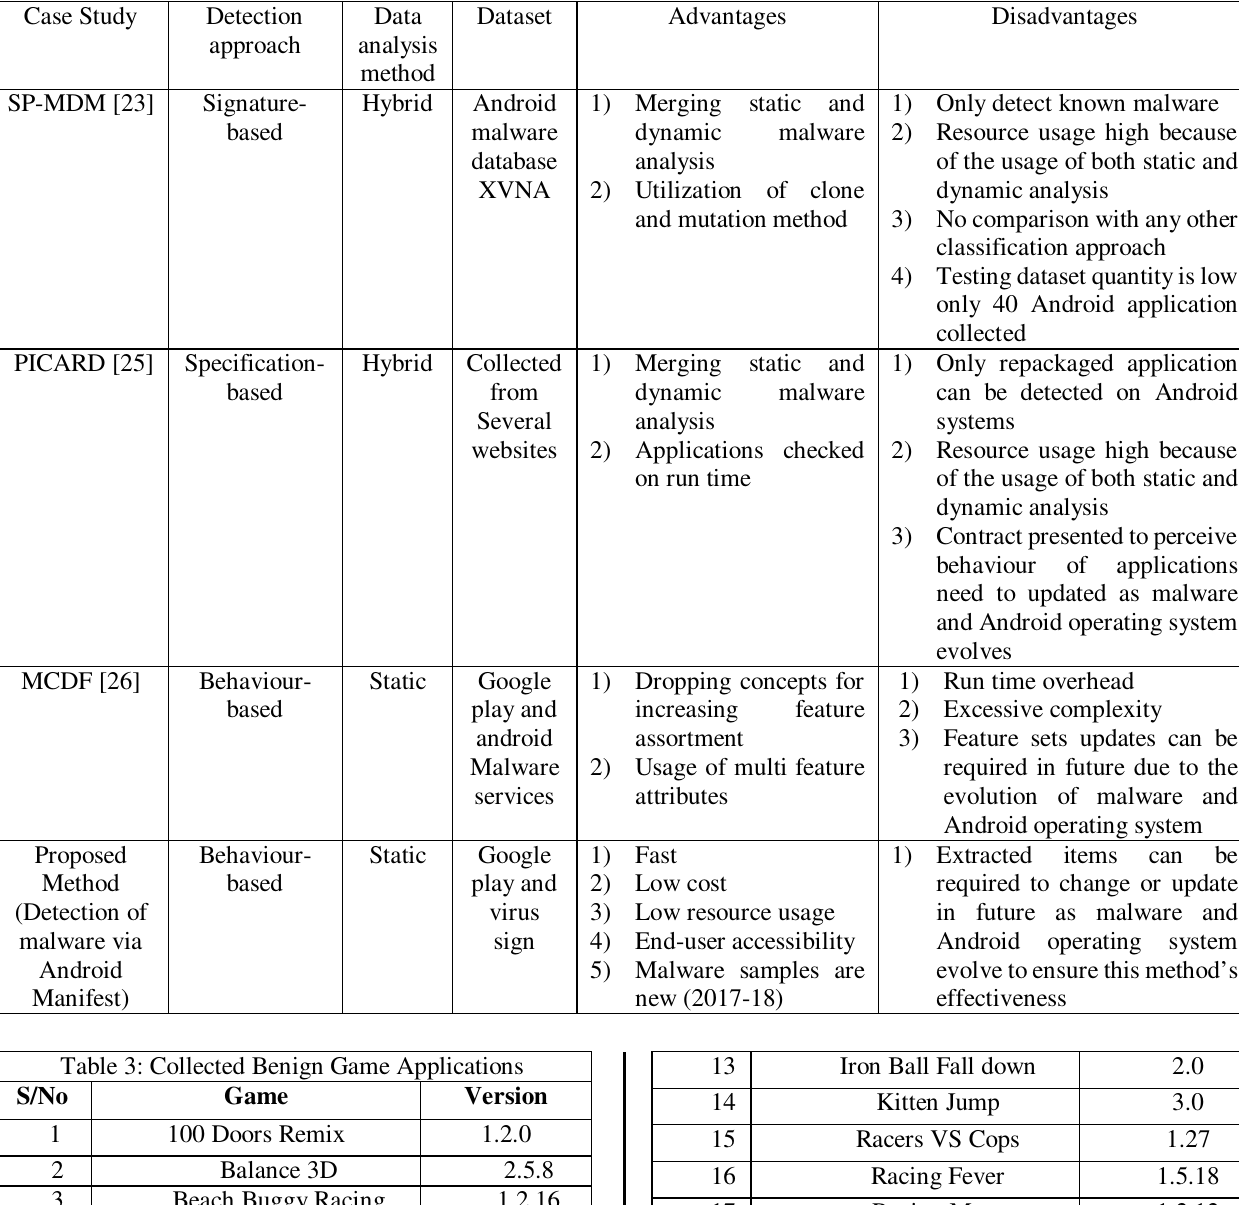
Table 2: Comparative Analysis of proposed and reviewed Malware Detection approaches